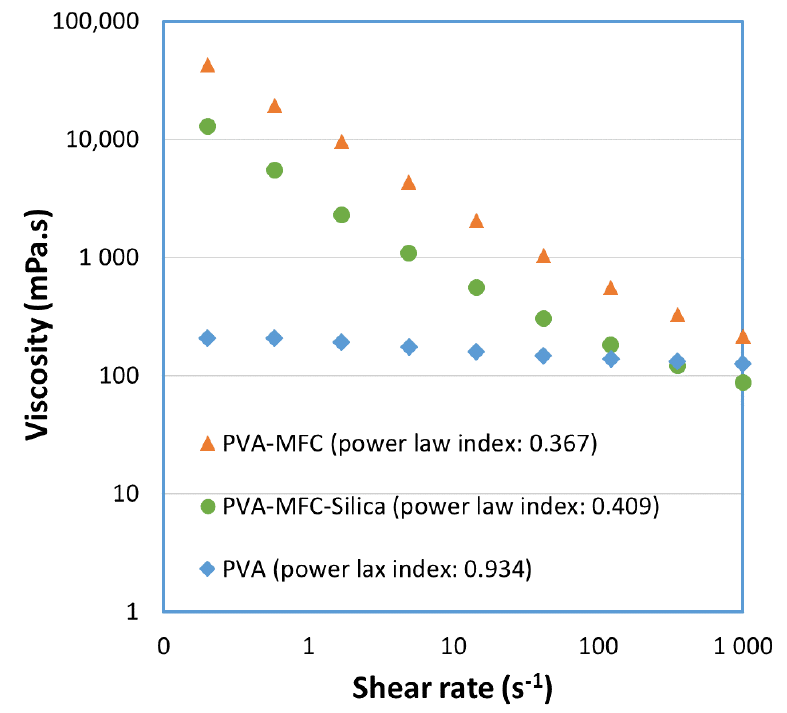
Figure 2. Viscosity against shear rate for the coating formulations. Table 2. Coat weights and barrier properties obtained with different formulations.